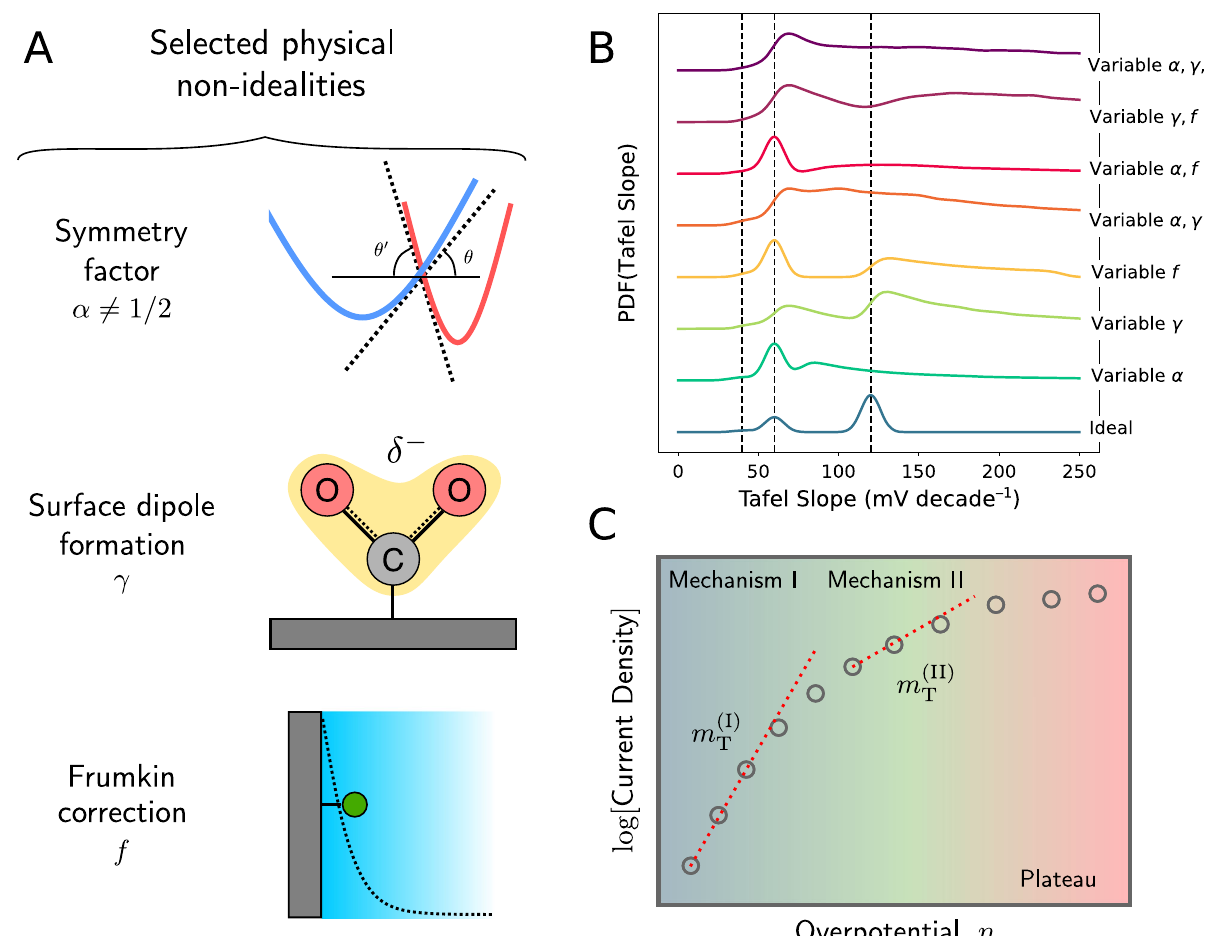
Fig. 4 Physical hypotheses for the lack of observed cardinality in literature Tafel slopes. A Schematic of three selected physical nonidealities that can affect the measured Tafel slope. B (blue trace) Synthetic kernel density estimate of the probability distribution over Tafel slopes for a random CO 2 reduction catalyst, peaked around the cardinal values predicted by Eq. (5). B (other traces) Several synthetic kernel density estimates of the probability distributions over the Tafel slope generated from including random values of different parameters governing physical nonidealities. C Schematic illustrating the possibility of measuring data across separate kinetic regimes in a Tafel analysis. Due to a switch in mechanism, different overpotential regimes exhibit different Tafel slopes, complicating interpretation of a single Tafel slope value fi t straddling both